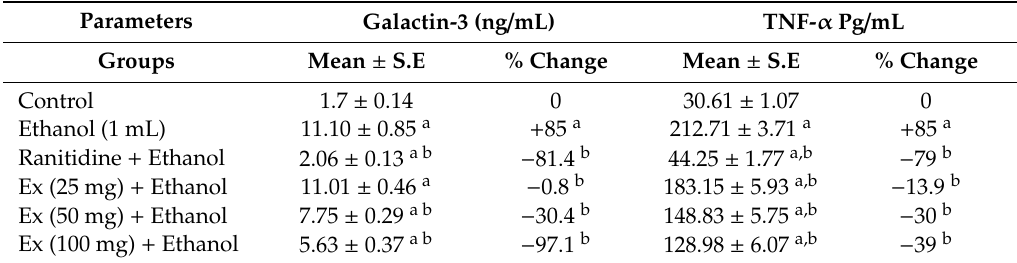
Table 2. E ff ects of oral administration of C. conglomeratus alcoholic extract on blood Galactin-3 (ng / mL) and TNF- α (Pg / mL) levels in ethanol-induced gastric ulcer in